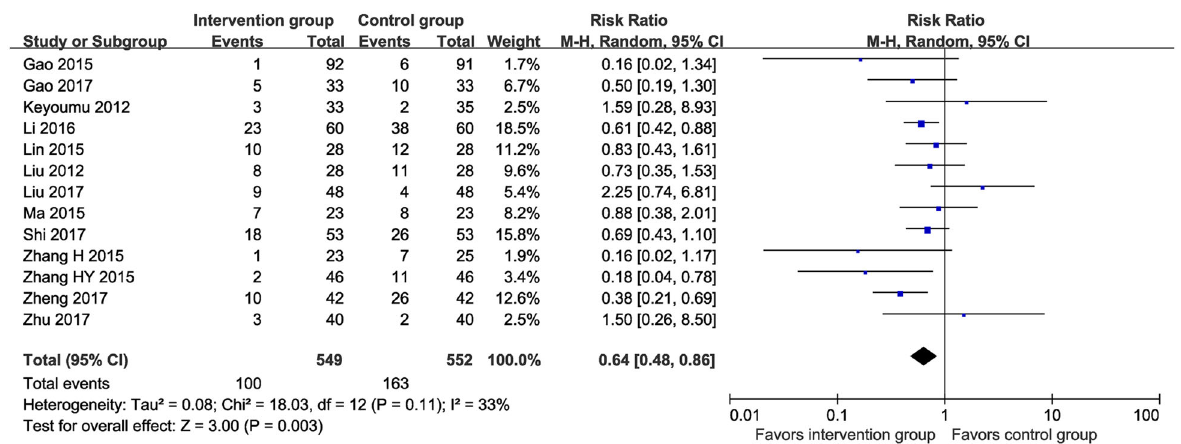
Fig. 6 Meta-analysis on incidence of